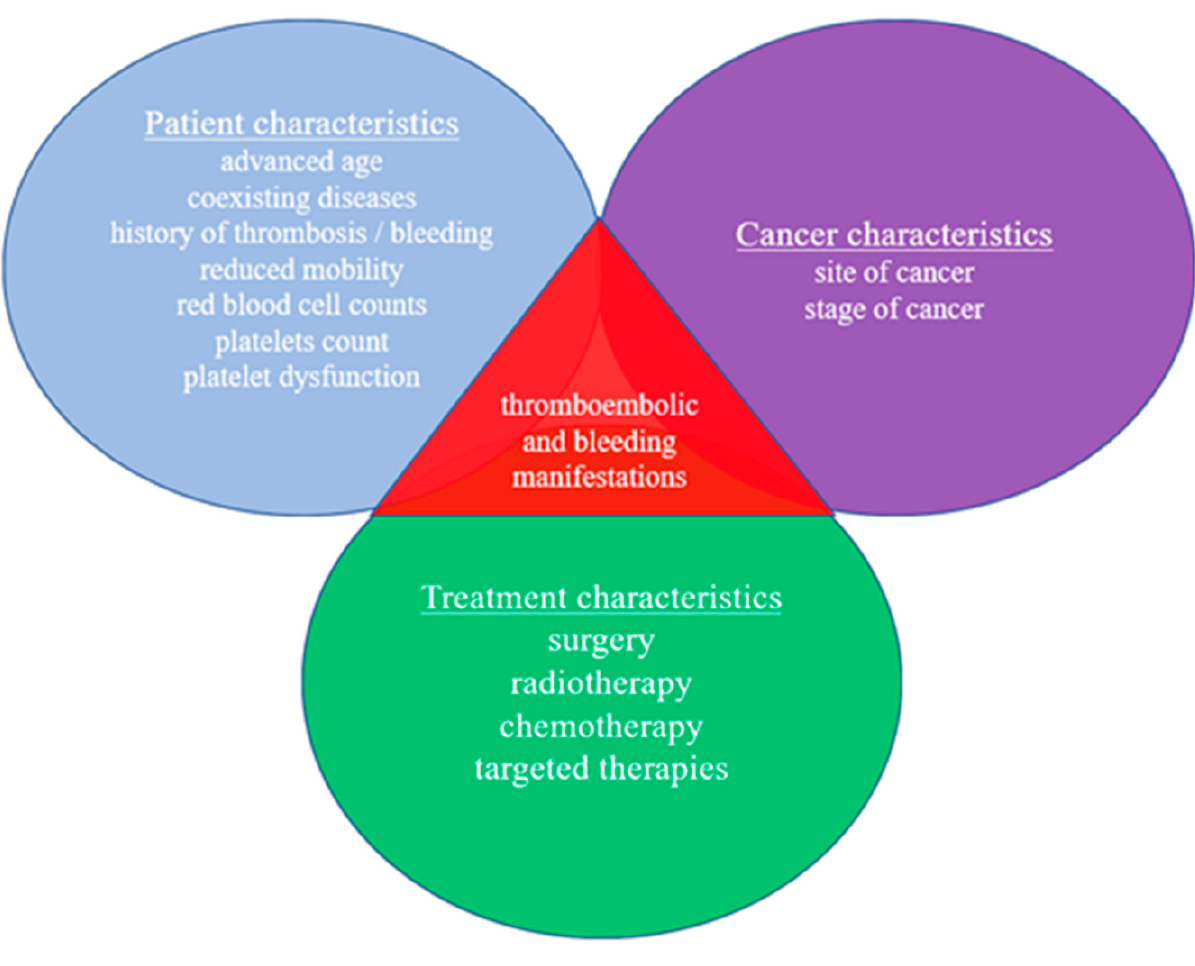
Figure 1. Clinical risk factors for both thromboembolic and bleeding manifestations in patients with cancer.